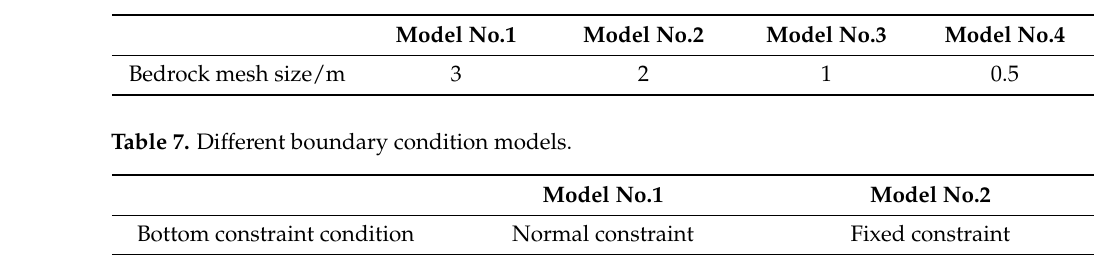
Table 6. Different bedrock mesh size models.